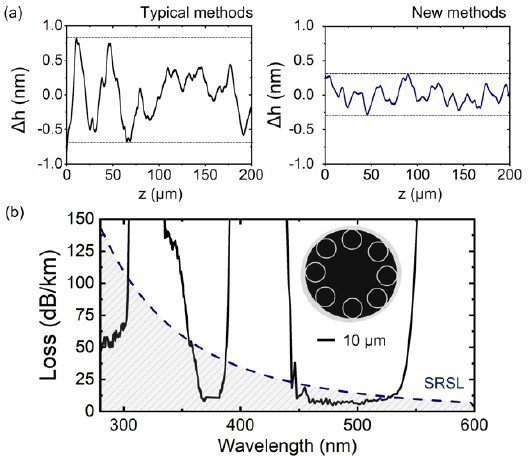
Fig. 1. Core surface profiles for HCPCF drawn by (a) typical and (b) innovative approaches. (c) Loss spectrum of a HCPCF with record low loss in the short-wavelength range. SRSL: silica Rayleigh scattering